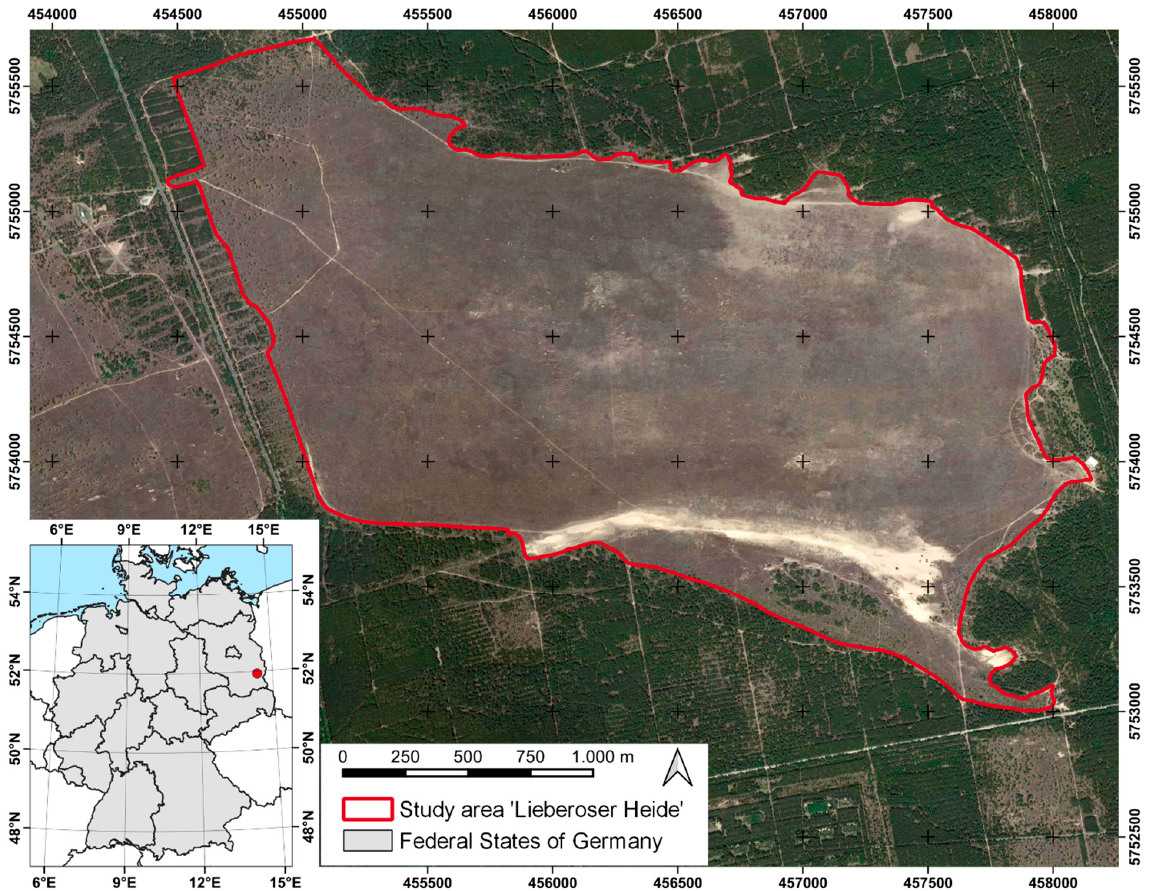
Figure 1. Location in context to Germany and high-resolution true-color satellite image of the study area ‘Lieberoser Heide’ acquired on Jun. 6, 2018. The projection is WGS (World Geodetic System) 84/UTM Universal Transverse Mercator (UTM) zone 33 N (epsg code 32633).